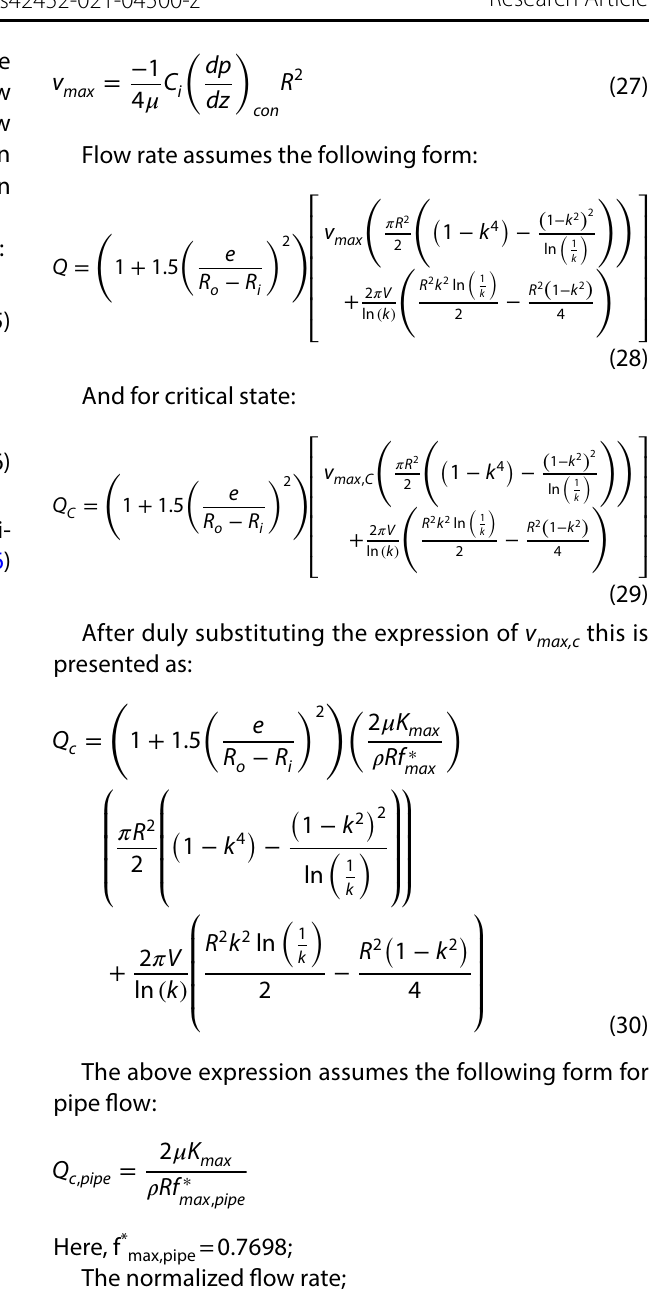
Extreme radial coordinates of inner locations and outer of the eccentric annulus